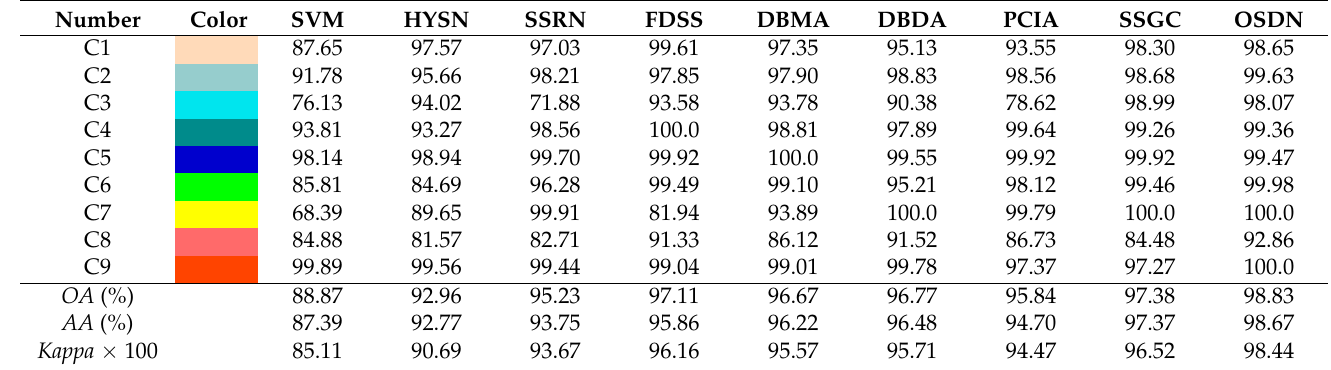
Table 11. Classification results of the PU dataset based on 1% training samples.